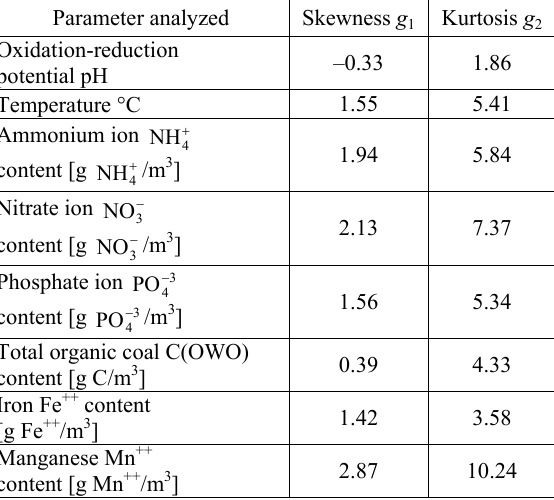
Fig. 8. Histogram of distribution of phosphate ion of Kłodzko (SW part of Poland); data coming from 14 wells Table 6. A comparison of values of skewness g 1 and kurtosis g 2 of distributions histograms of quality parameters in the intake area of underground water in region of Kłodzko (14 wells) (year